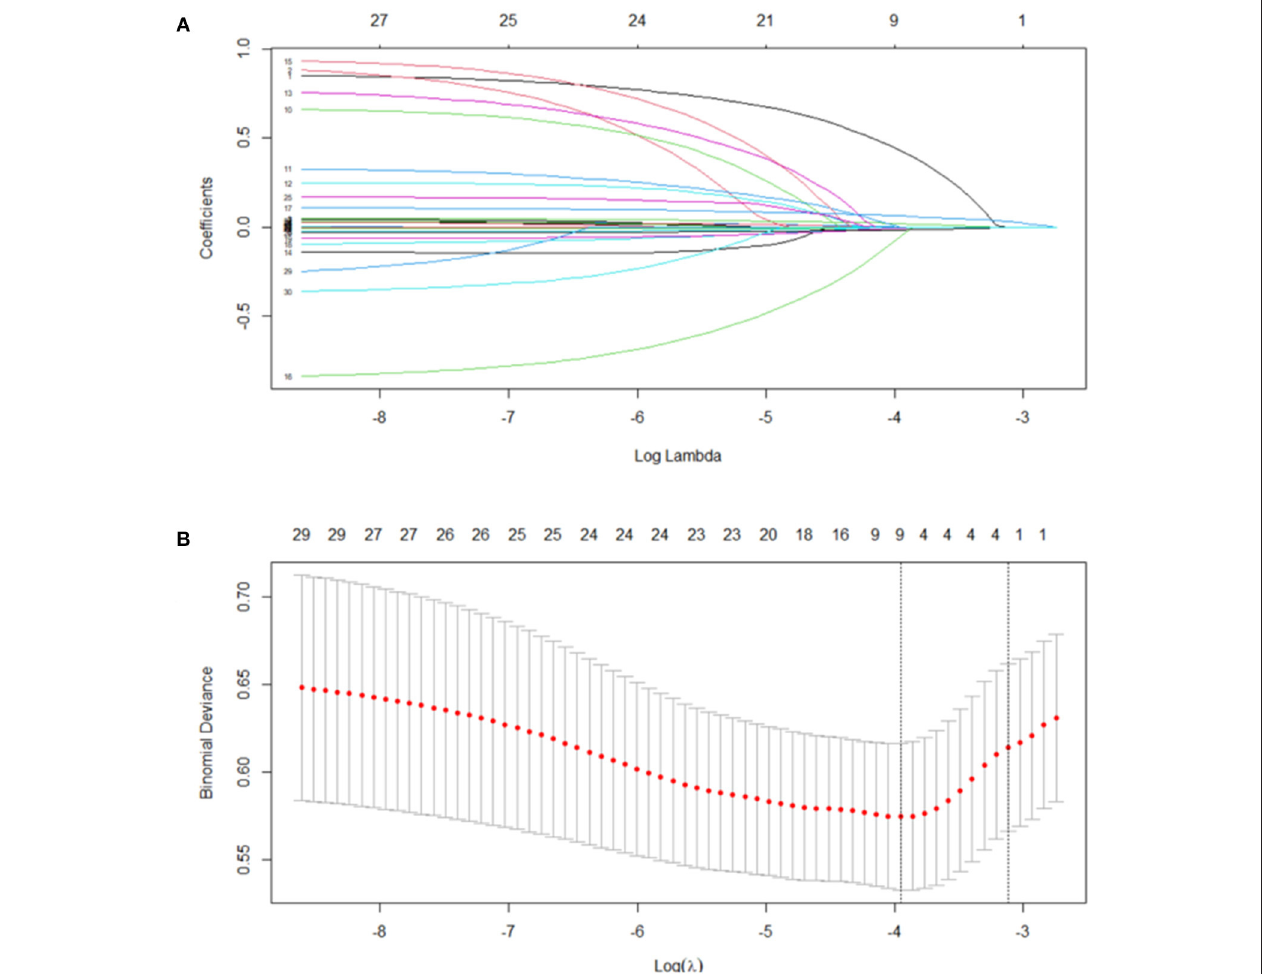
FIGURE 1 | Feature selection using the least absolute shrinkage and selection operator binary logistic regression model. (A) Binomial deviance was plotted against the log (lambda) sequence. (B) A coefficient profile plot was produced against the log ( λ ) sequence. In this study, predictors were selected according to the minimum criteria. Four nonzero coefficients (age, left atrial diameter, Pulmonary arterial hypertension and rest left ventricular outflow gradient) were selected to construct a Atrial fibrillation risk predictive model.